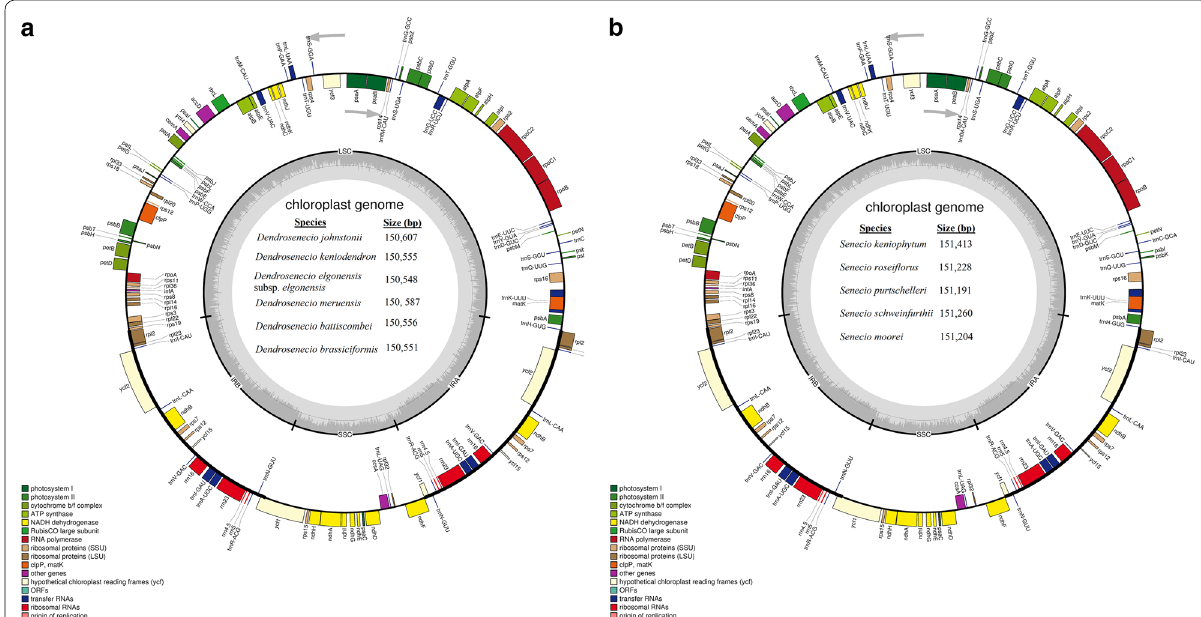
Fig. 1 A representative chloroplast genome map of a Dendrosenecio and b Senecio . Genes are color-coded based on their function as shown in the legend. The inner circle indicates the inverted repeat boundaries and the genome’s GC content. The arrows indicate the direction of gene